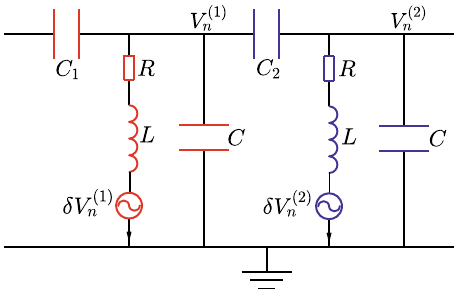
Fig. 5 Experimental proposal of the nonlinear topoelectrical metamaterial. The unit cell of the active topological circuit is depicted by the fi gure. The inductances are connected by the external alternating voltage sources δ V ð j ¼ 1 ; 2 Þ n , which are nonlinearly controlled by the voltage fi elds V ð j ¼ 1 ; 2 Þ